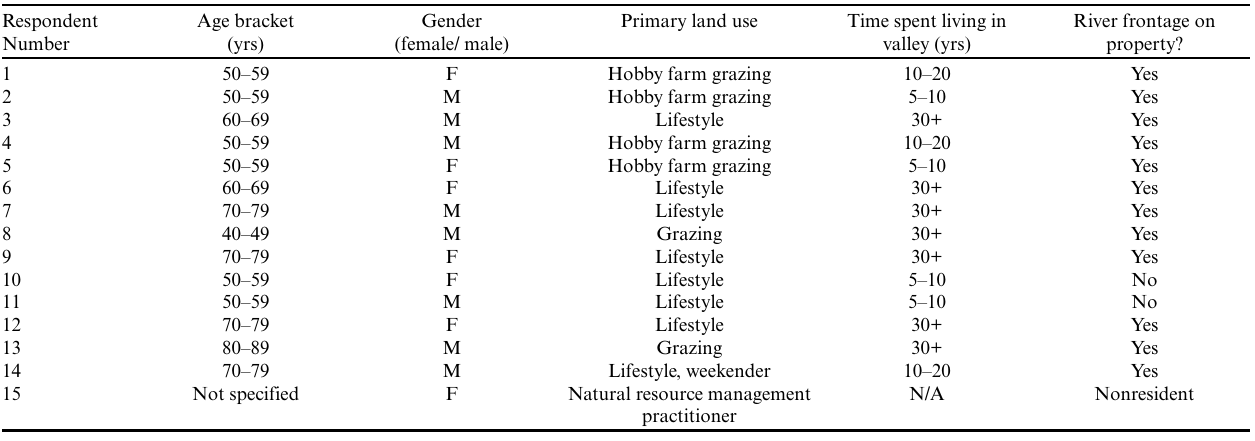
Table 1 . Respondents in research, assigned random numbers.